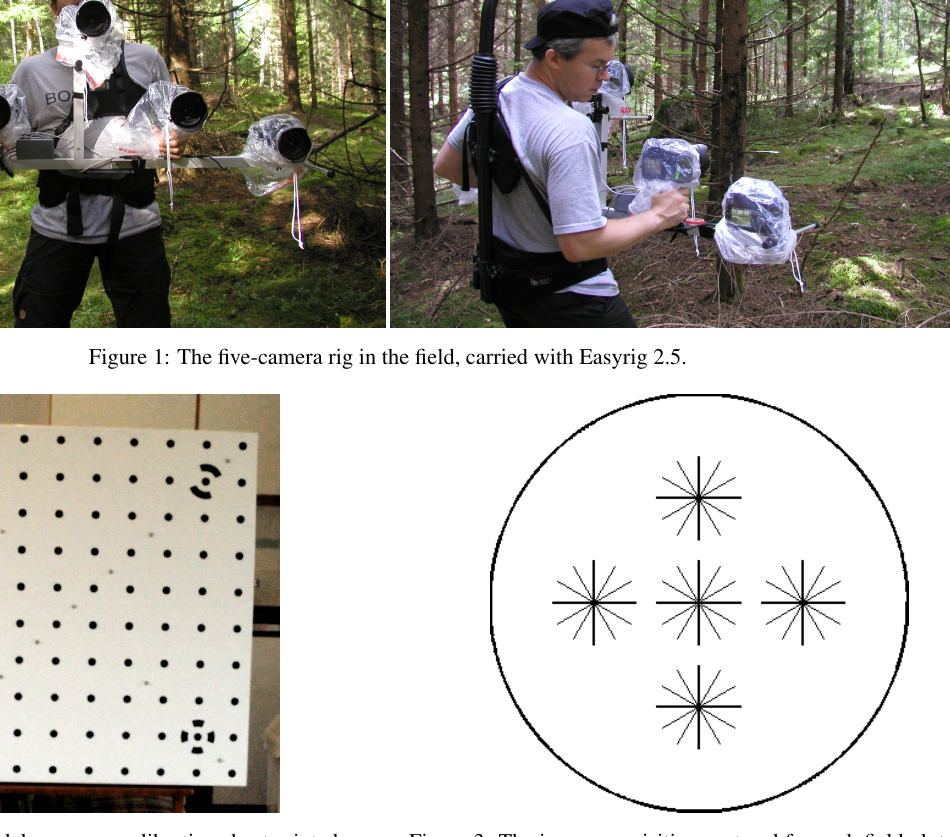
Figure 3: The image acquisition protocol for each field plot con- sisted of a central camera station and four satellite stations. The satellite stations were approximately 10 m from the center in the four cardinal directions. At each station, images were taken in 12 directions separated by approximately 30